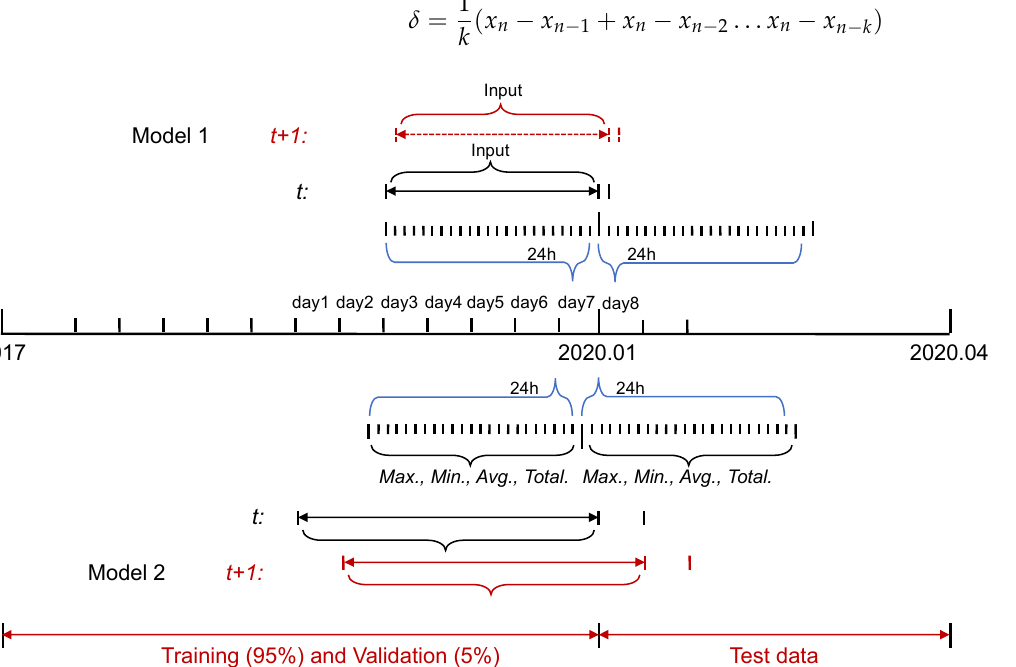
Figure 3. Illustration of data generation process in two predictive models using BP-ANN and LSTM. Parameter tunning is the necessary step for predictive process. The mean average percentage error (MAPE) and correlation coefficient were applied in the model tunning process for the gradient loss learning. To find the suitable technique, each kind of predictive model was adjusted. The sizes of original and reduced urban microclimate training datasets are 315,360 (5-min resolution) and 26,280 (1-h resolution) for real-time prediction and 1097 for characteristic prediction. The range of batch size was 16, 32, 64, 128; the epochs are from 60 to 180 in the step of 10, and optimizer is “leakyRele”, “Adam” and “SGD”. In model 2, the range of batch size was 16, 32, 64, 128; the epochs are from 60 to 180 in the step of 10, and optimizer is “leakyRele”, “Adam” and “SGD”. While for the validation test,